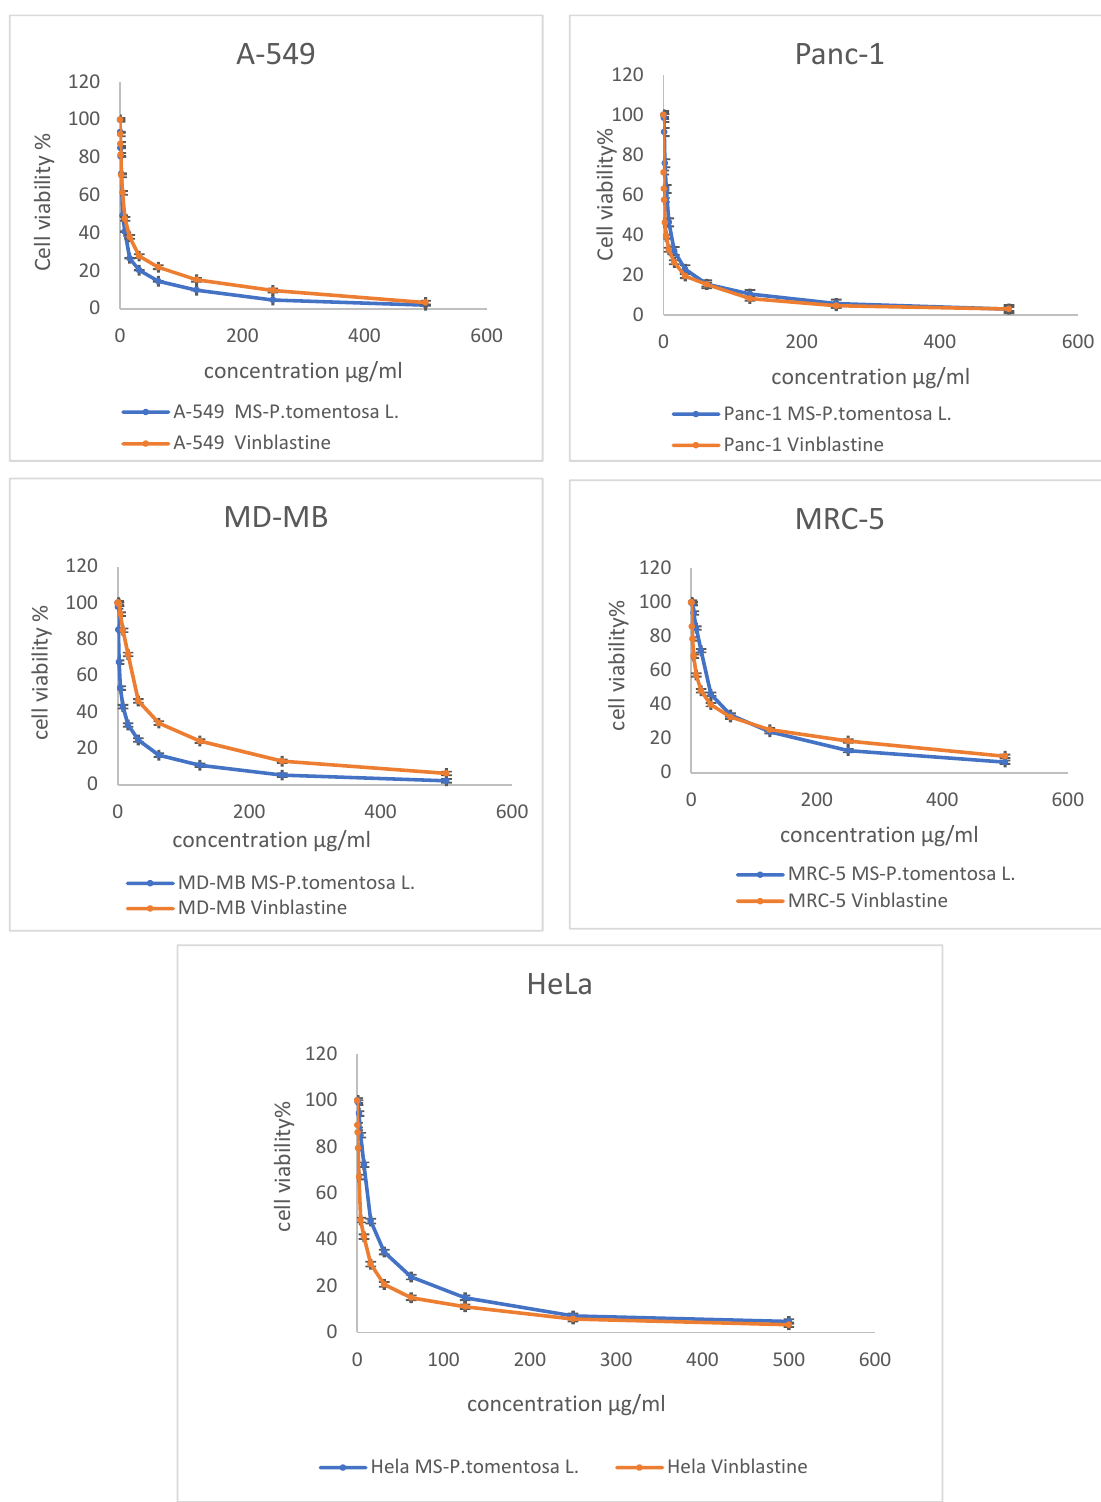
Figure 1. Demonstrated dose response profile of the plant latex from P. tomentosa L. on the cell viability of A-495, Panc-1, MDA-MB-231, MRC-5, and HeLa cell lines following incubation for 24 h. All data are represented as the mean ± SD, n = 3.